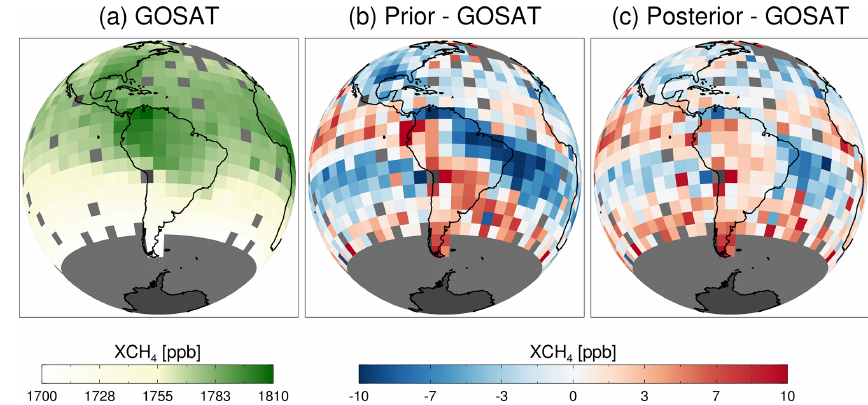
Figure 2. (a) Mean GOSAT XCH 4 over South America and surrounding area for 2009–2018. Observations have been averaged onto the TOMCAT model grid as described in the text. Also shown is the mean difference between the model and satellite XCH 4 using (b) the prior emissions and (c) the posterior emissions for the same period.